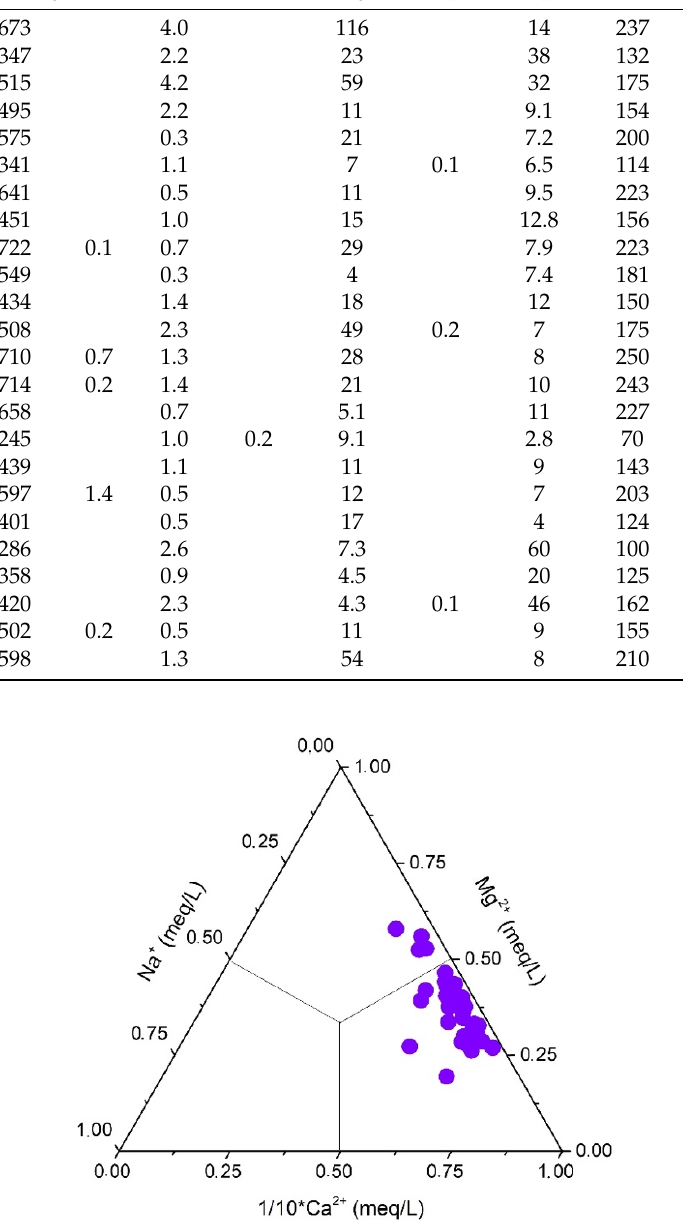
Figure 3. The cation triangular diagram of the CO 2 -saturated water leachates. The concentrations of metals and metalloids (in µ g · L − 1 ), ordered according to the increasing atomic number, and SiO 2 (in mg · L − 1 ) in the leachates, are listed in Table 6. Aluminum, Mn, and Fe varied between 34 and 1148, 3.1 and 280 and 5 and 568 µ g · L − 1 , respectively. As and Sb showed concentration up to 102 and 661 µ g · L − 1 , respectively. Mercury showed concentrations up to 7 µ g · L − 1 although most samples were below the instrumental detection limit (0.1 µ g · L − 1 , Table 4) or slightly higher. Finally, SiO 2 contents were included between 3.7 and 10.1 mg·L − 1 .